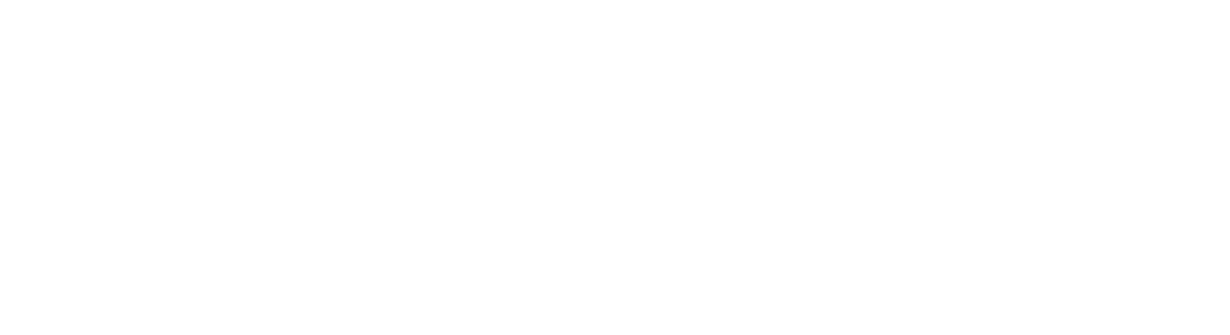
Frontiers in Energy Research |